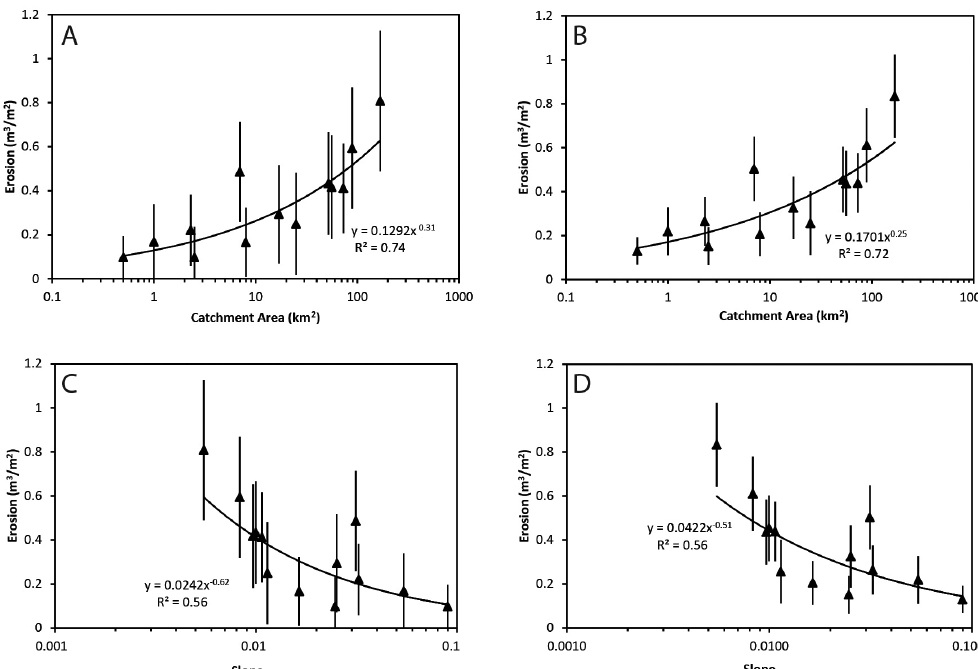
Figure 7. Relationship between catchment area and normalised erosion ( a – b ) and channel slope and normalised erosion ( c – d ) for 3 field and 10 desktop reaches in the upper Lockyer Valley, derived from DoDs between the 2010 and 2011 lidar data. Errors in ( a ) and ( c ) represent 0.44m min LoD values whereas (b) and (d) represent 0.23m min